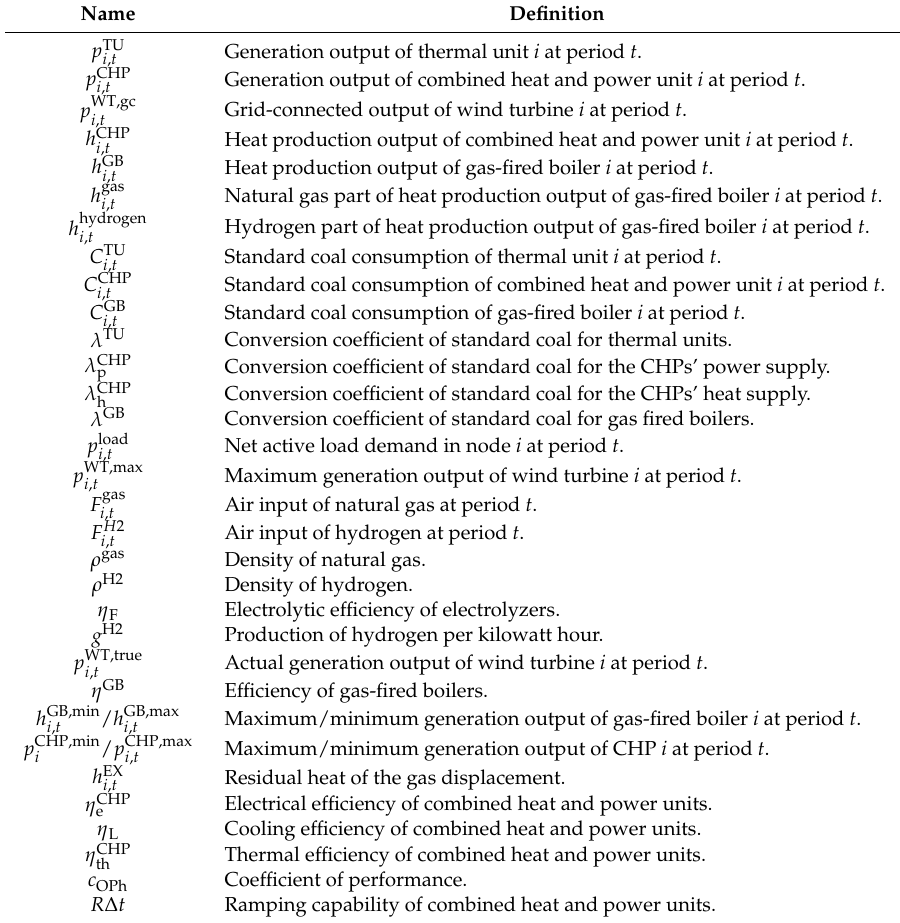
Table 1. Parameters and